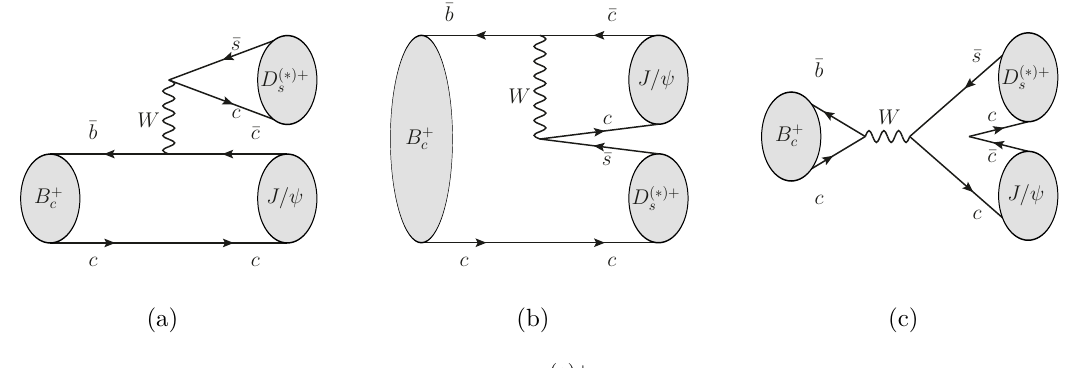
Figure 1 . Feynman diagrams for B + → J/ψD ( ∗ )+ s decays: (a) colour-favoured spectator, (b) c colour-suppressed spectator, and (c) annihilation